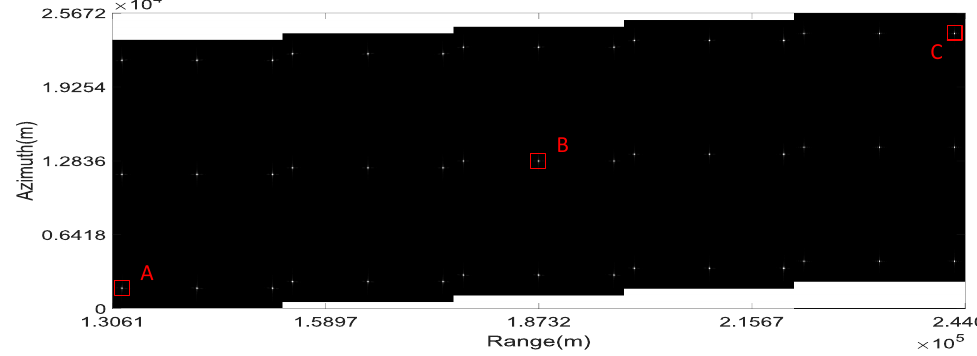
Figure 6. Imaging result of the proposed scheme.